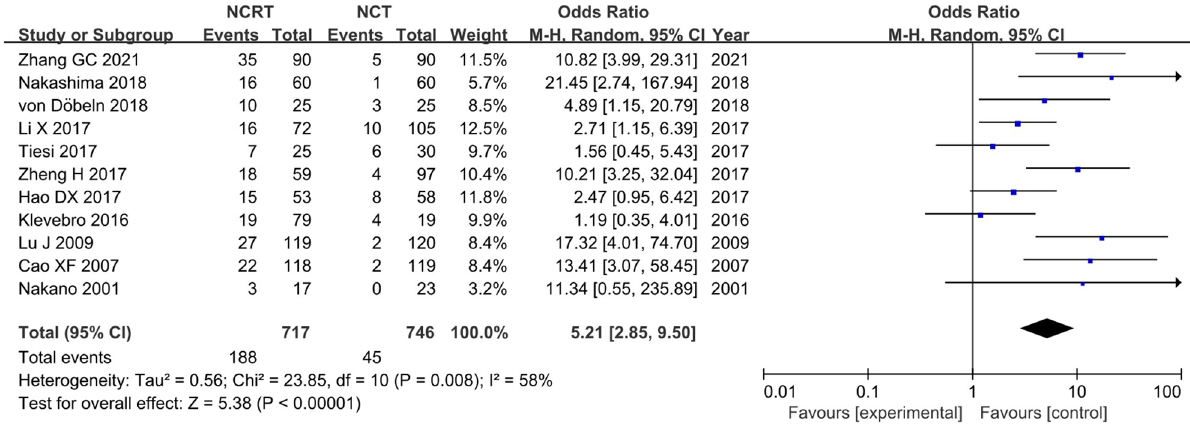
Fig 3. Forest plot for pCR of NCRT group and NCT group.